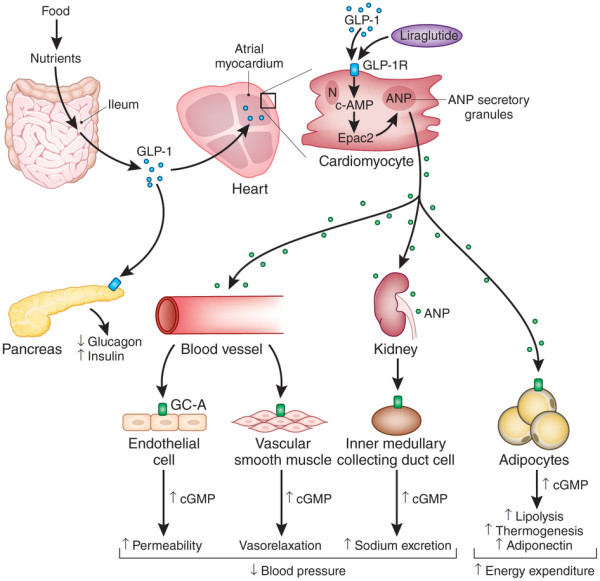
Cardiometabolic actions of GLP-1 and GLP-1 agonists [7].